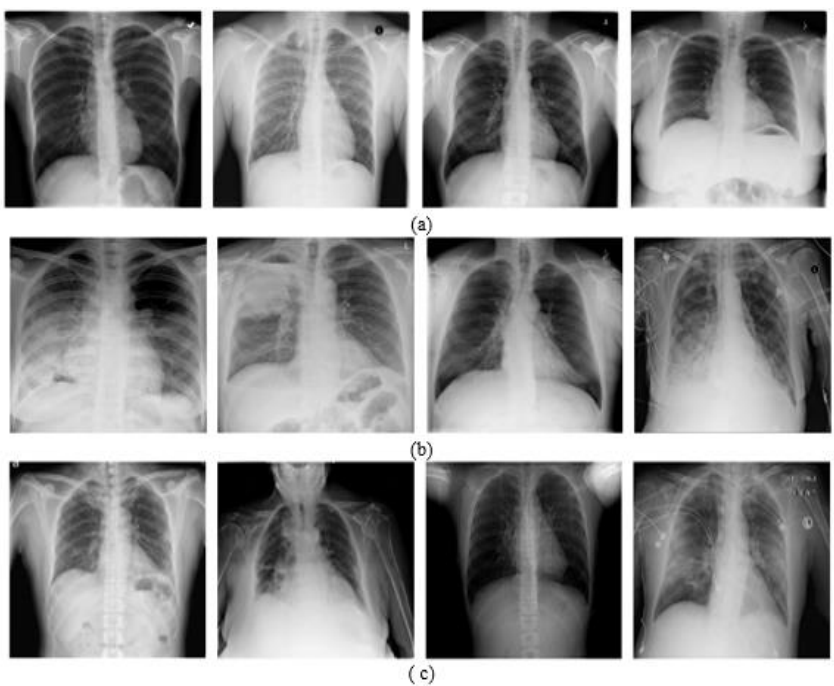
Figure 2. Samples of patients from the COVIDx dataset: ( a ) healthy (normal), ( b ) pneumonia, and ( c ) COVID-19. Table 1. Numbers of images per class in the COVIDX dataset.